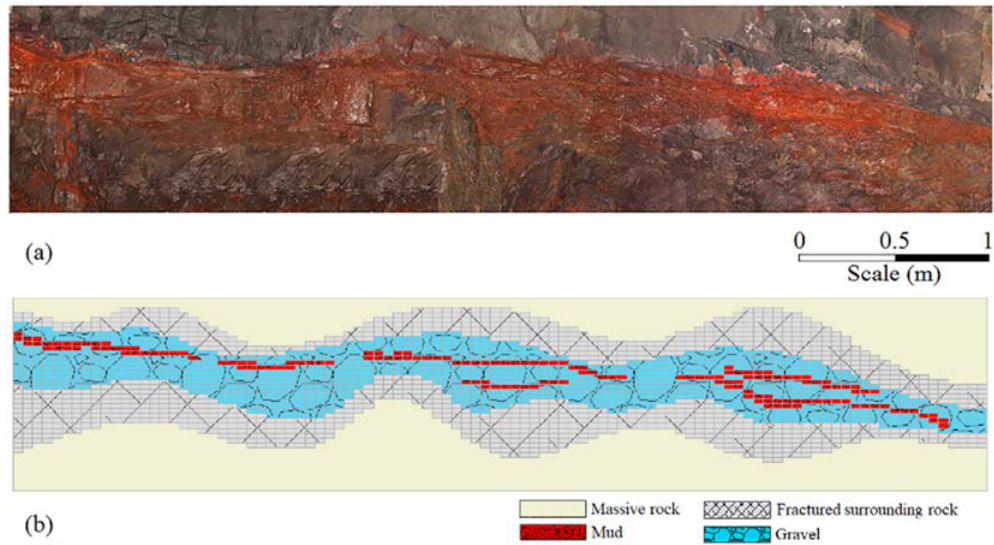
Figure 2. Massive rock containing an ISWZ (C 3 ) which is located at the right bank of the Baihetan dam site area with the buried depth of about 500 m: ( a ) The picture of C 3 taken at the scene; ( b ) The corresponding structure diagram.